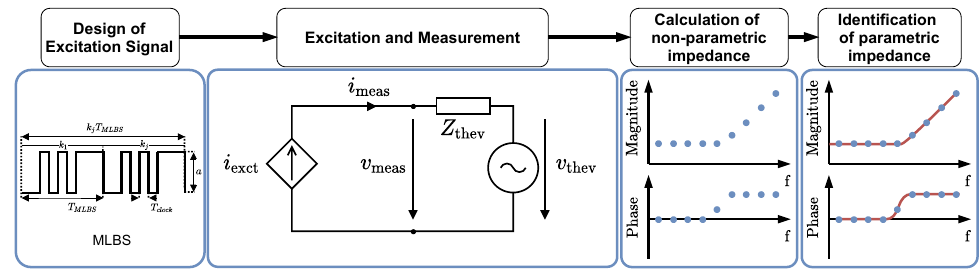
Figure 2. General procedure for impedance